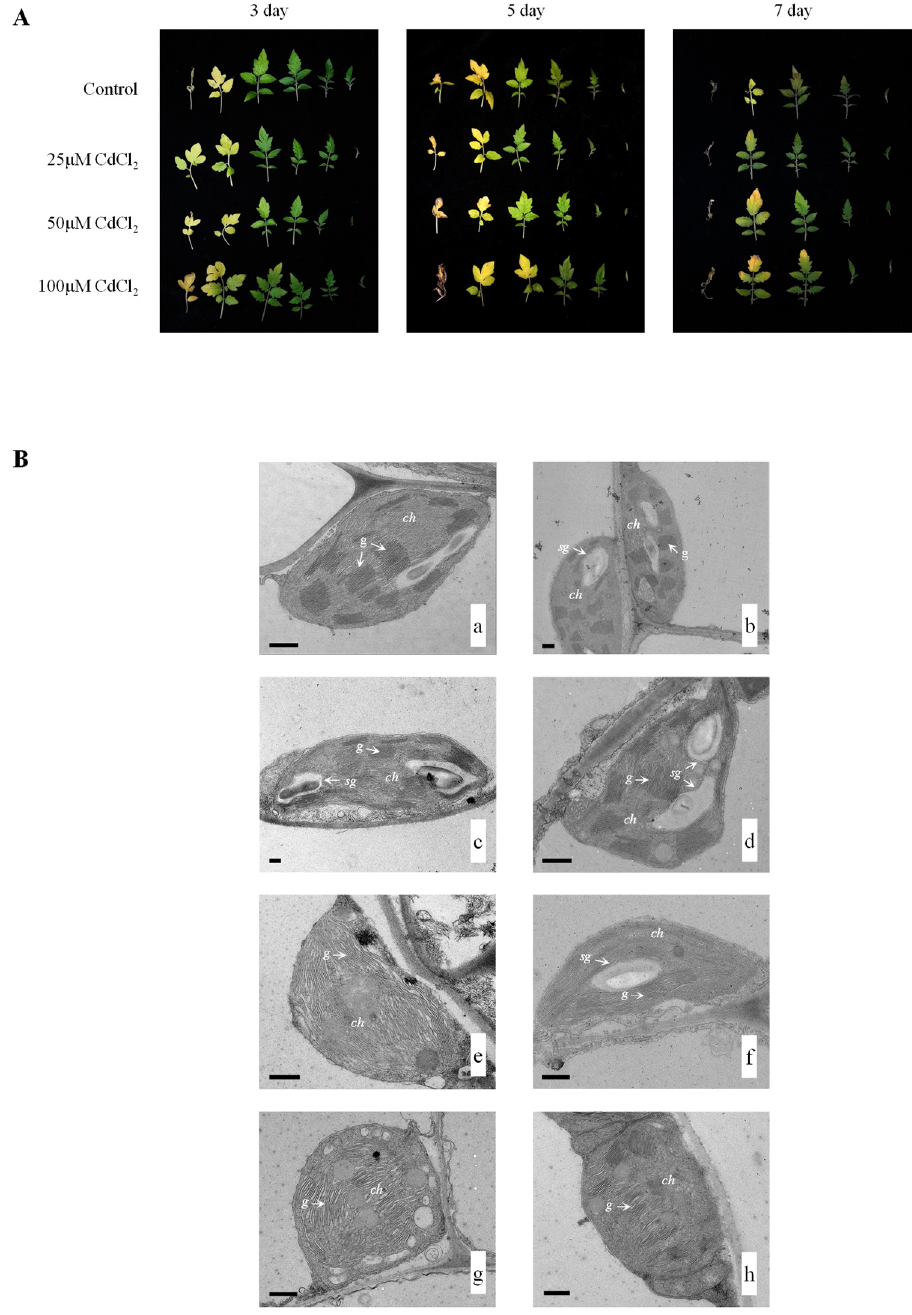
Figure 1. Phenotype of Solanum lycopersicum L. leaves under cadmium treatment. ( A ) Phenotype of leaves yellowing. ( B ) Ultrastructure of tomato leaves. ( a , b ) Control groups; ( c – h ) cadmium treatment groups; ( c , d ) under 25 µ M CdCl 2 treatment; ( e , f ) under 50 µ M CdCl 2 treatment; ( g , h ) under 100 µ M CdCl 2 treatment. ( a , c , e , g ) Samples of the third leaves after treatment; ( b , d , f , h ) samples of the fourth leaves after treatment. Abbreviations: ch , chloroplasts; g , granum thylakoid; sg , starch grain. All bars = 500 nm.